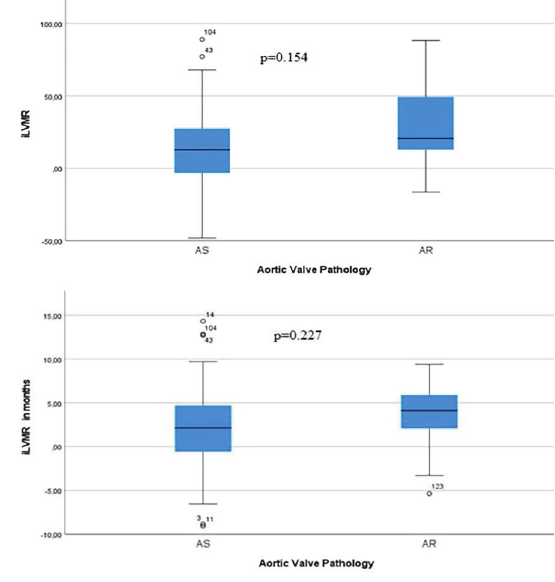
Figure 2. - Left ventricular mass regression indexes after